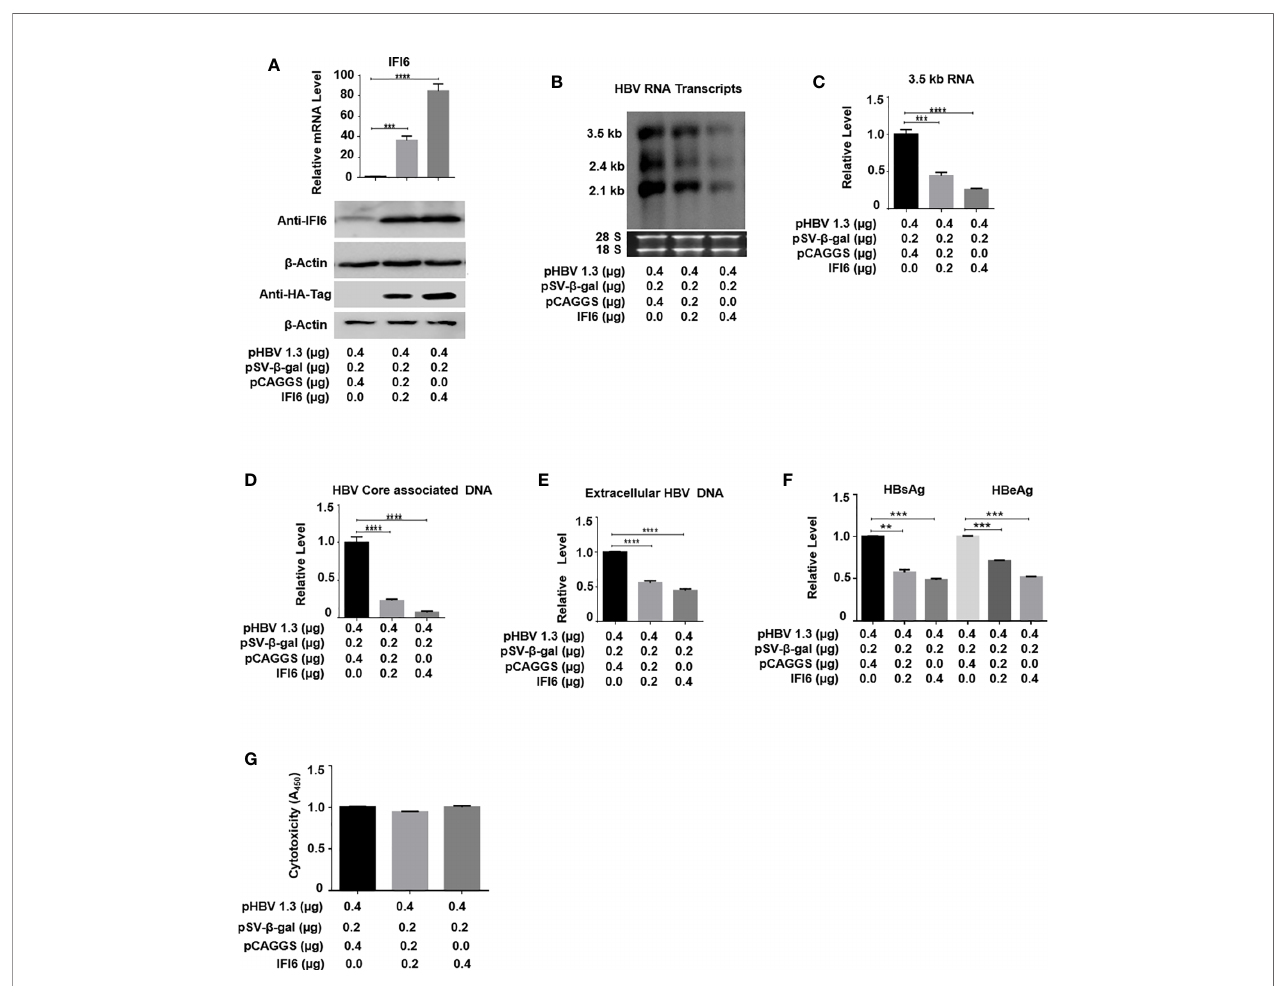
FIGURE 2 | IFI6 overexpression inhibits HBV replication and gene expression. HepG2 cells were seeded in 12 well cell culture plates and transfected with indicated amounts of the plasmid. Cells were harvested after 48 h posttransfection (A, B, C, F, G) or 96 hours post-transfection (D, E). (A) The expression of IFI6 mRNA and protein was measured by qRT-PCR and western blot, respectively. The anti-IFI6 and anti-HA-tag antibodies were used to determine the protein level of IF6 and HA-tag, respectively. The b -actin was used as a loading control. (B) HBV RNA transcripts (3.5 kb, 2.4 kb, and 2.1 kb) were determined with northern blot. The amount of 28S and 18S rRNAs was used as a loading control. (C) The level of HBV 3.5 kb RNA was measured with qRT-PCR. The GAPDH level was used as an internal control. HBV core associated (D) and extracellular DNA (E) was determined by qPCR. (F) The level of secreted HBsAg and HBeAg from transfected cell supernatant was measured with ELISA. (G) The cytotoxicity of transfected HepG2 was determined with a CCK8 kit after 48 hours of transfection with the indicated amount of plasmids. The data are averages of three independent experiments; the results were measured as a mean ± SD and were statistically measured. *** P < 0.001, **** P <